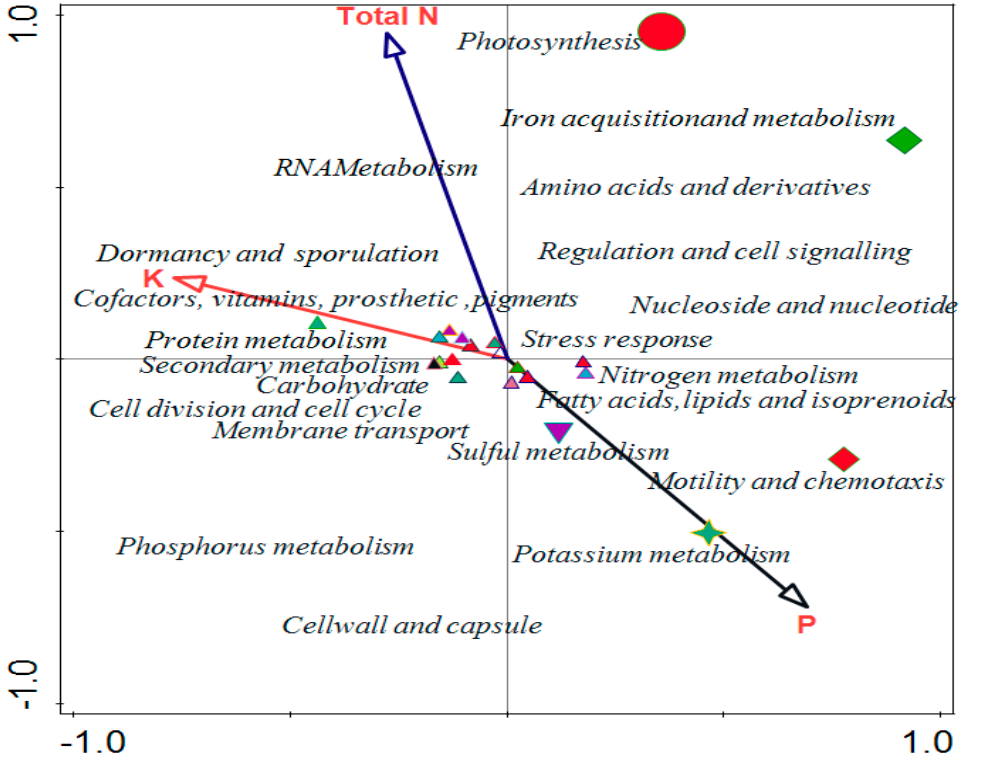
Figure 6. Canonical correspondence analysis showing the effect of physicochemical parameters on functional categories in the rhizosphere. AA, AB, and CA are rhizosphere soil samples while BC is a bulk soil sample. Table 3. Selection of variables in the environment that best explain the differences in functional composition of the microbes’ habitat using canonical correspondence analysis .